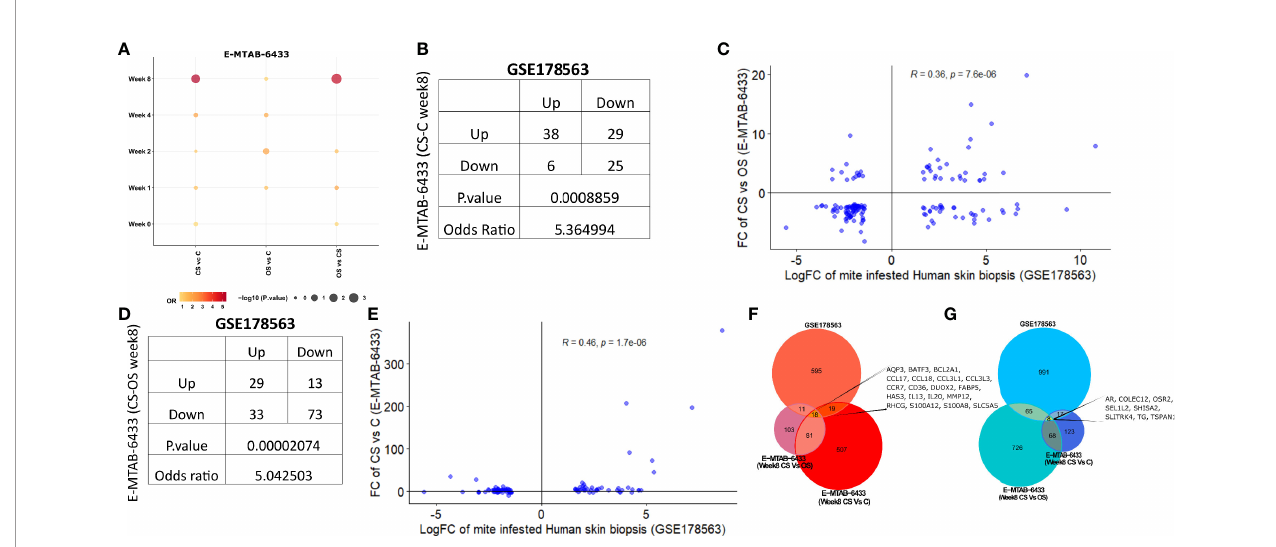
FIGURE 6 | Comparative analysis of GSE178563 (mite-infested human skin biopsies) with E-MTAB-6433 (mite-infested pig biopsies). (A) Association between signi fi cantly modulated differential expression pro fi les of human infested skin biopsies with each time point (Week 0,1,2,4,8) of porcine infested groups. Association statistics (contingency table along with odds ratio and fi sher ’ s exact p-value) and correlation plots of signi fi cant porcine groups, i.e (1)., CS vs. C (B, C) and (2) CS vs. OS (D, E) . Combined Venn diagram of all signi fi cantly associated groups identi fi ed in (F, G) (Week 8 CS vs. C and Week 8 CS vs. OS mite-infested human samples vs.